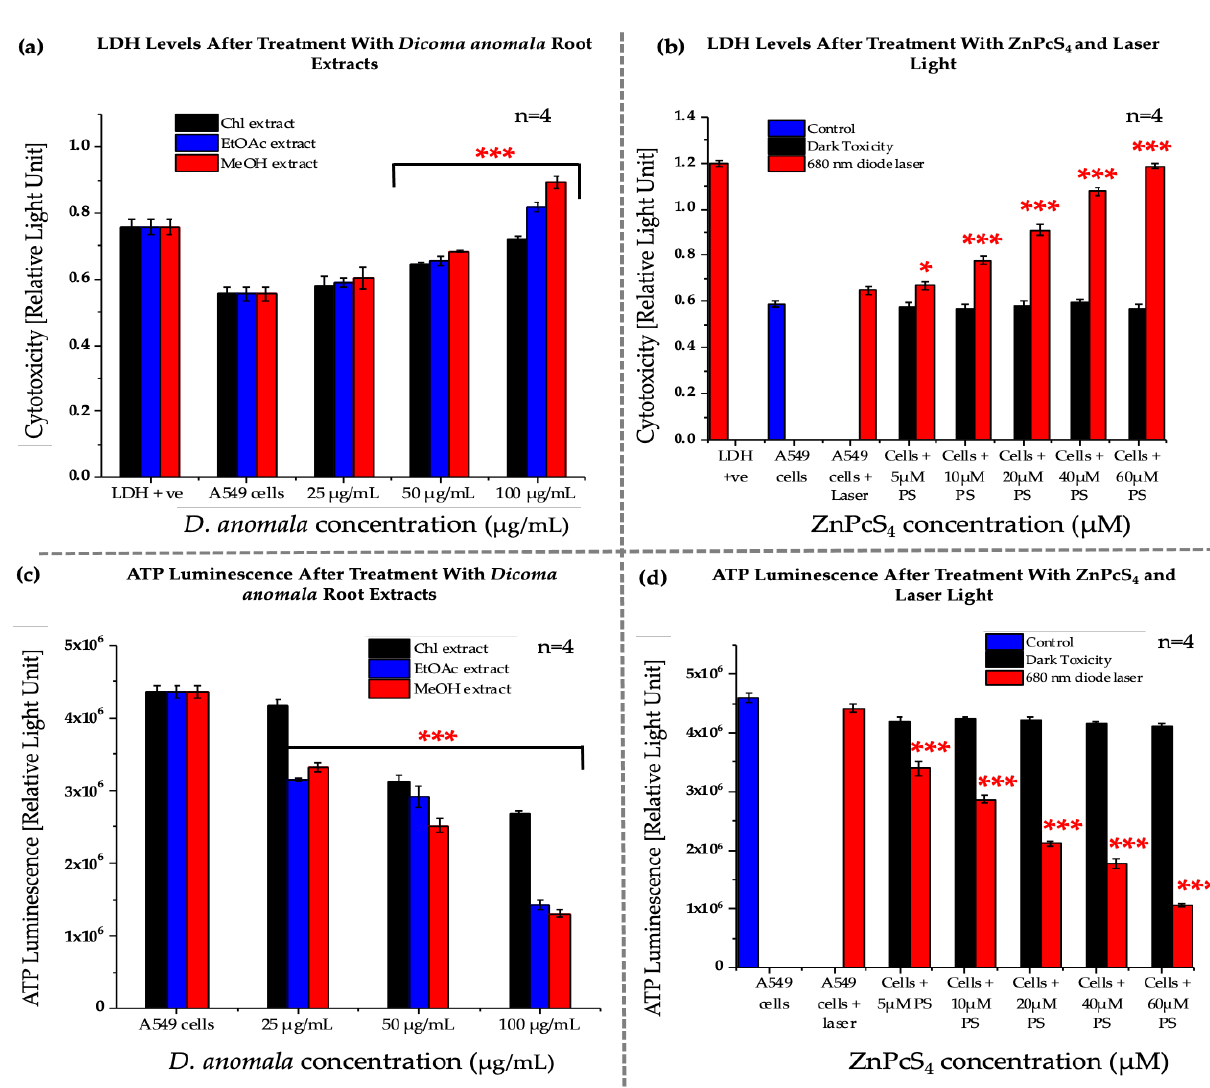
Figure 5. LDH cytotoxicity ( a , b ), and ATP proliferation ( c , d ) in A549 cells post-treatment with D.A (Chl, EtOAc, and MeOH) ( a ), and ZnPcS 4 . The values depicted in ( a , b ) are mean ± standard errors. Significant mean differences of independent treatments are represented as * p < 0.05, and *** p < 0.001.